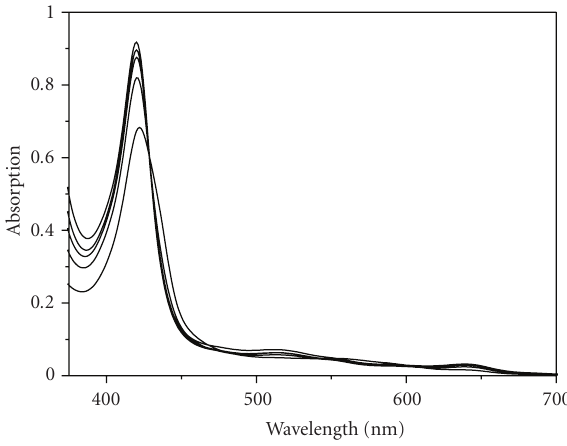
Figure 2: Absorption spectrum of ZnPP in the presence of colloidal TiO 2 in the concentration range of (0–5) × 10 − 4 M in